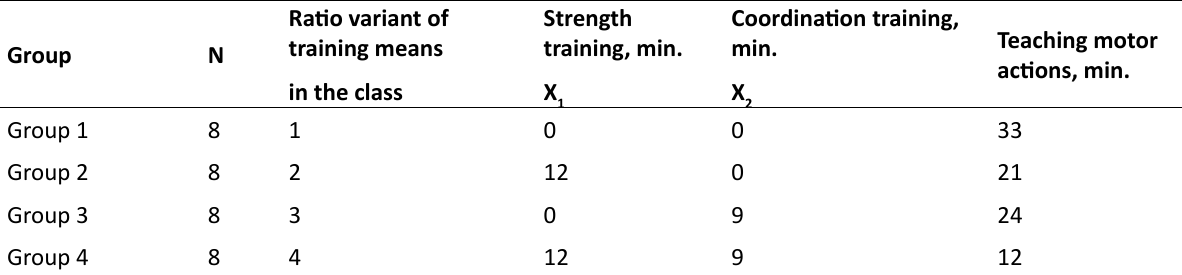
Table 1. Matrix of the 2 2 factorial experiment in studying the influence of ratio variants of training means in the class on the level of strength, coordination fitness and proficiency in motor actions in boys aged 8-9 years